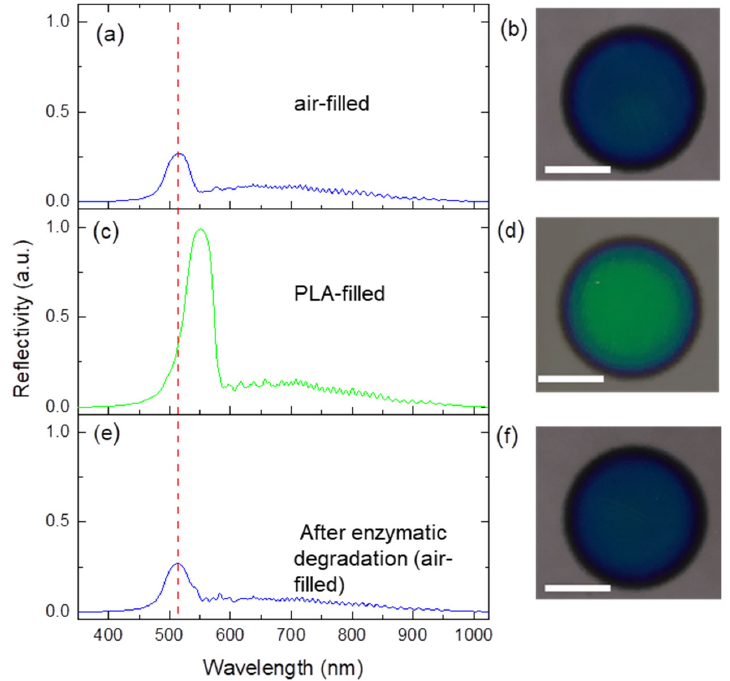
Figure 3. RIfS spectra and photographs of dried pSiRF: ( a , b ) air-filled pSiRF, ( c , d ) PLA-filled pSiRF and ( e , f ) pSiRF after enzymatic degradation of PLA with proteinase K (scale bars = 0.5